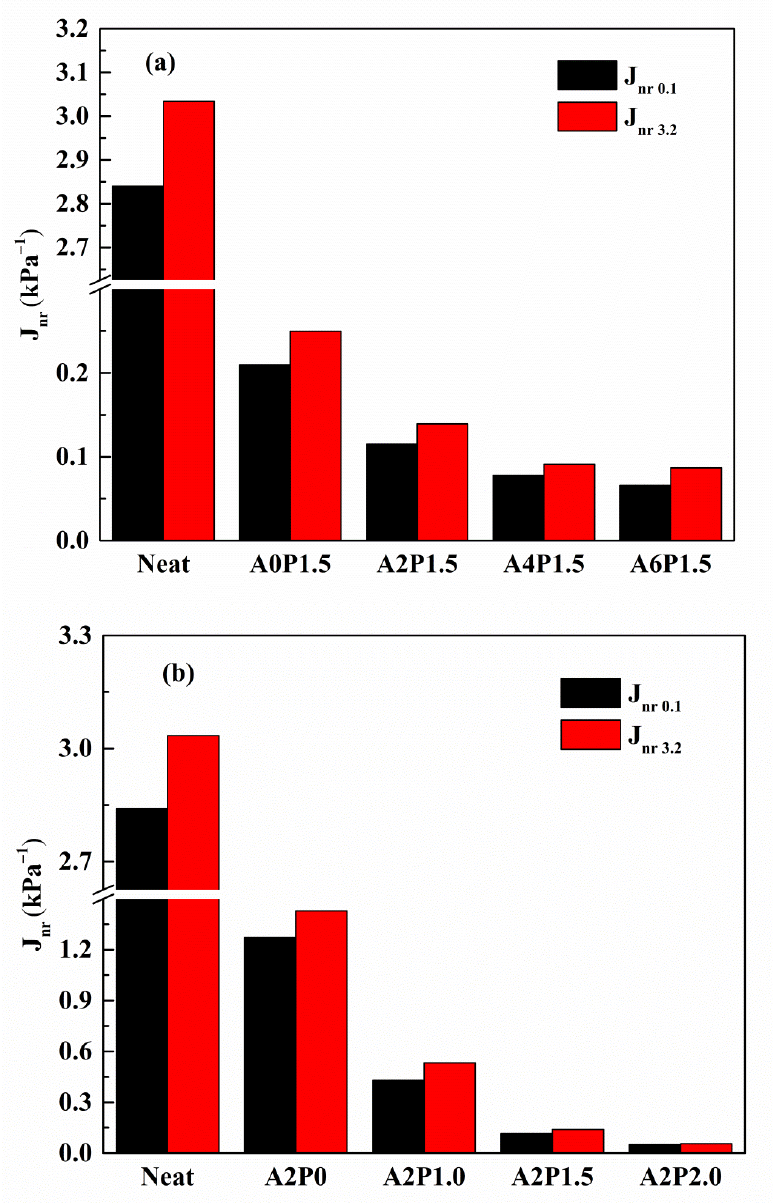
Figure 10. The J nr of composite modified binders under 0.1 kPa and 3.2 kPa at 60 °C: ( a ) composite modified binders with various contents of APAO; ( b ) composite modified binders with various contents of PPA.